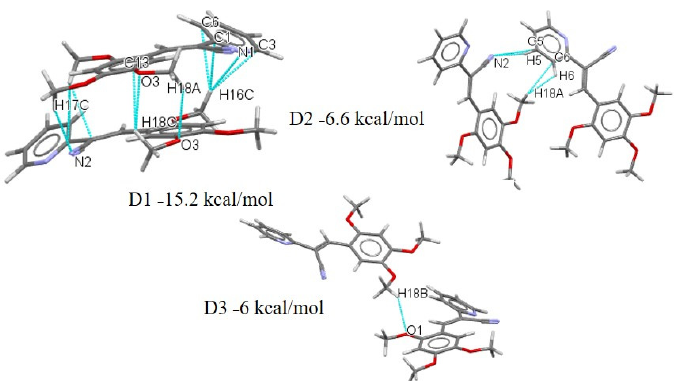
Figure 18. Different dimers (D1–D3) with interactions in the III crystal structure with respective interaction energies.